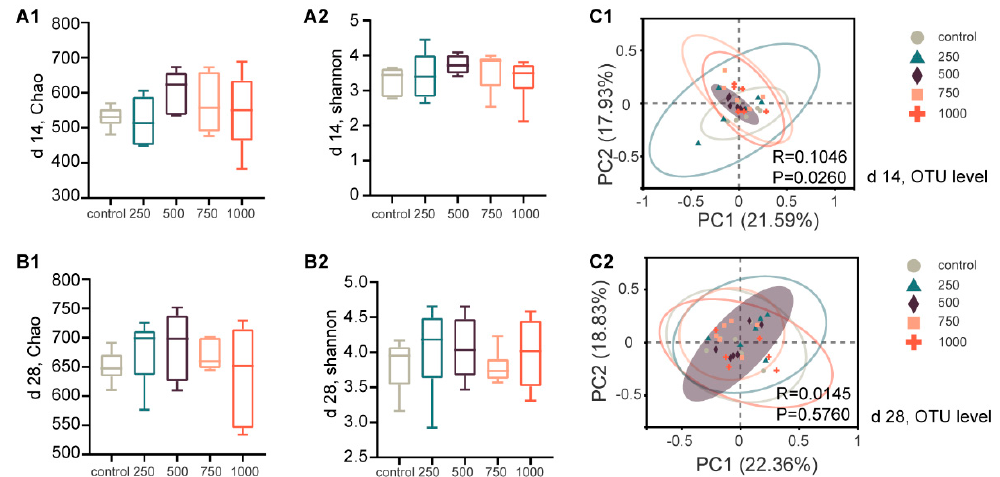
Figure 2. Microbiota changes in diversity and structure. ( A , B ) Alpha diversity comparisons of microbial communities (d 14: A1 , A2 ; d 28: B1 , B2 ). ( C1 , C2 ) PCoA of 16s genes. Using an OTU definition